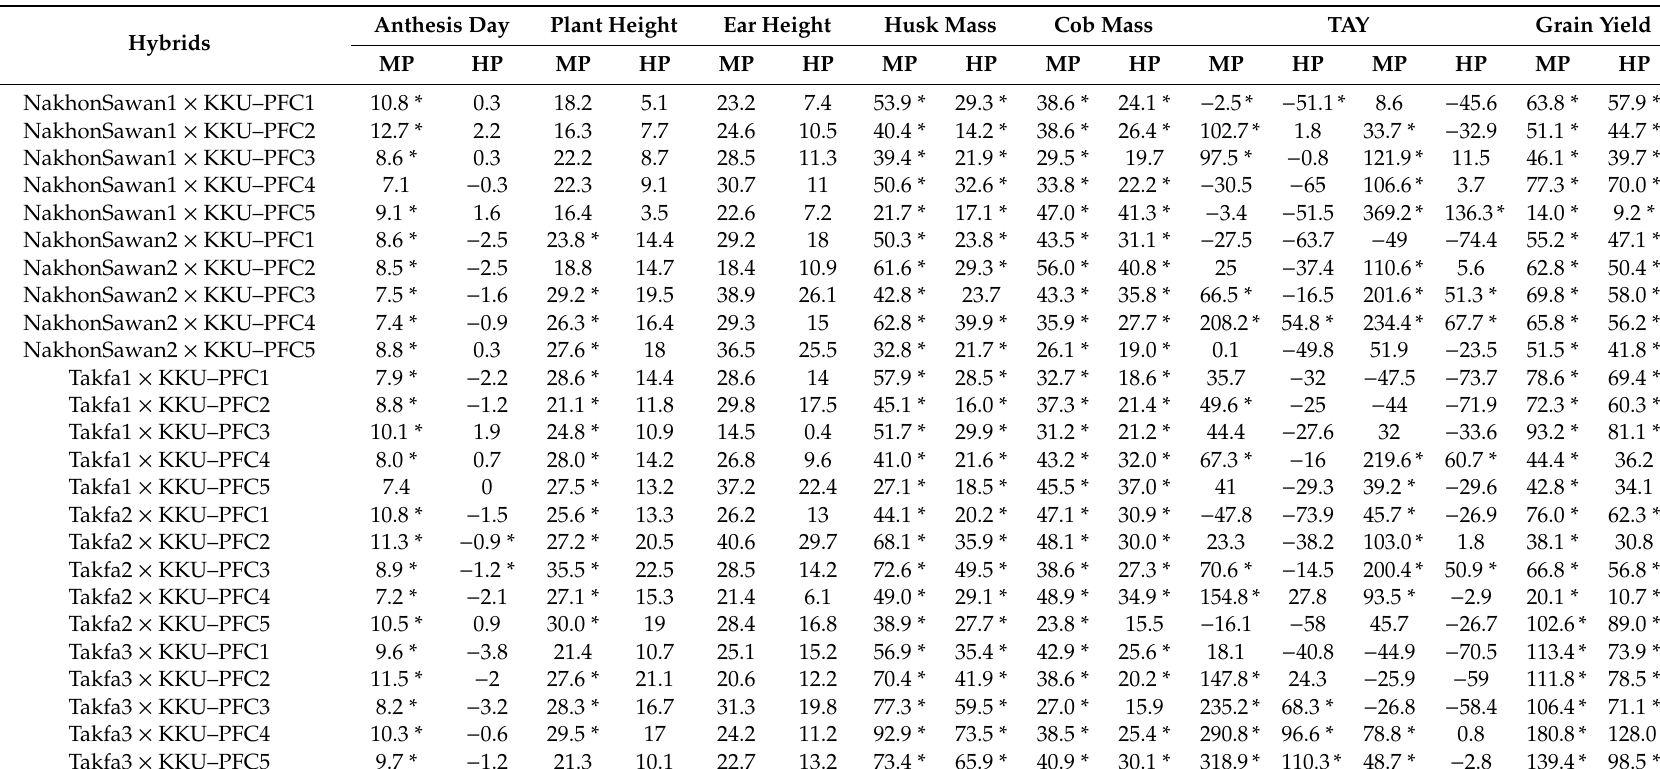
Table 8. Mid-parents heterosis (MP) and high-parents heterosis (HP) estimates for agronomic traits, anthocyanin yield, and grain yield of hybrids across two locations.